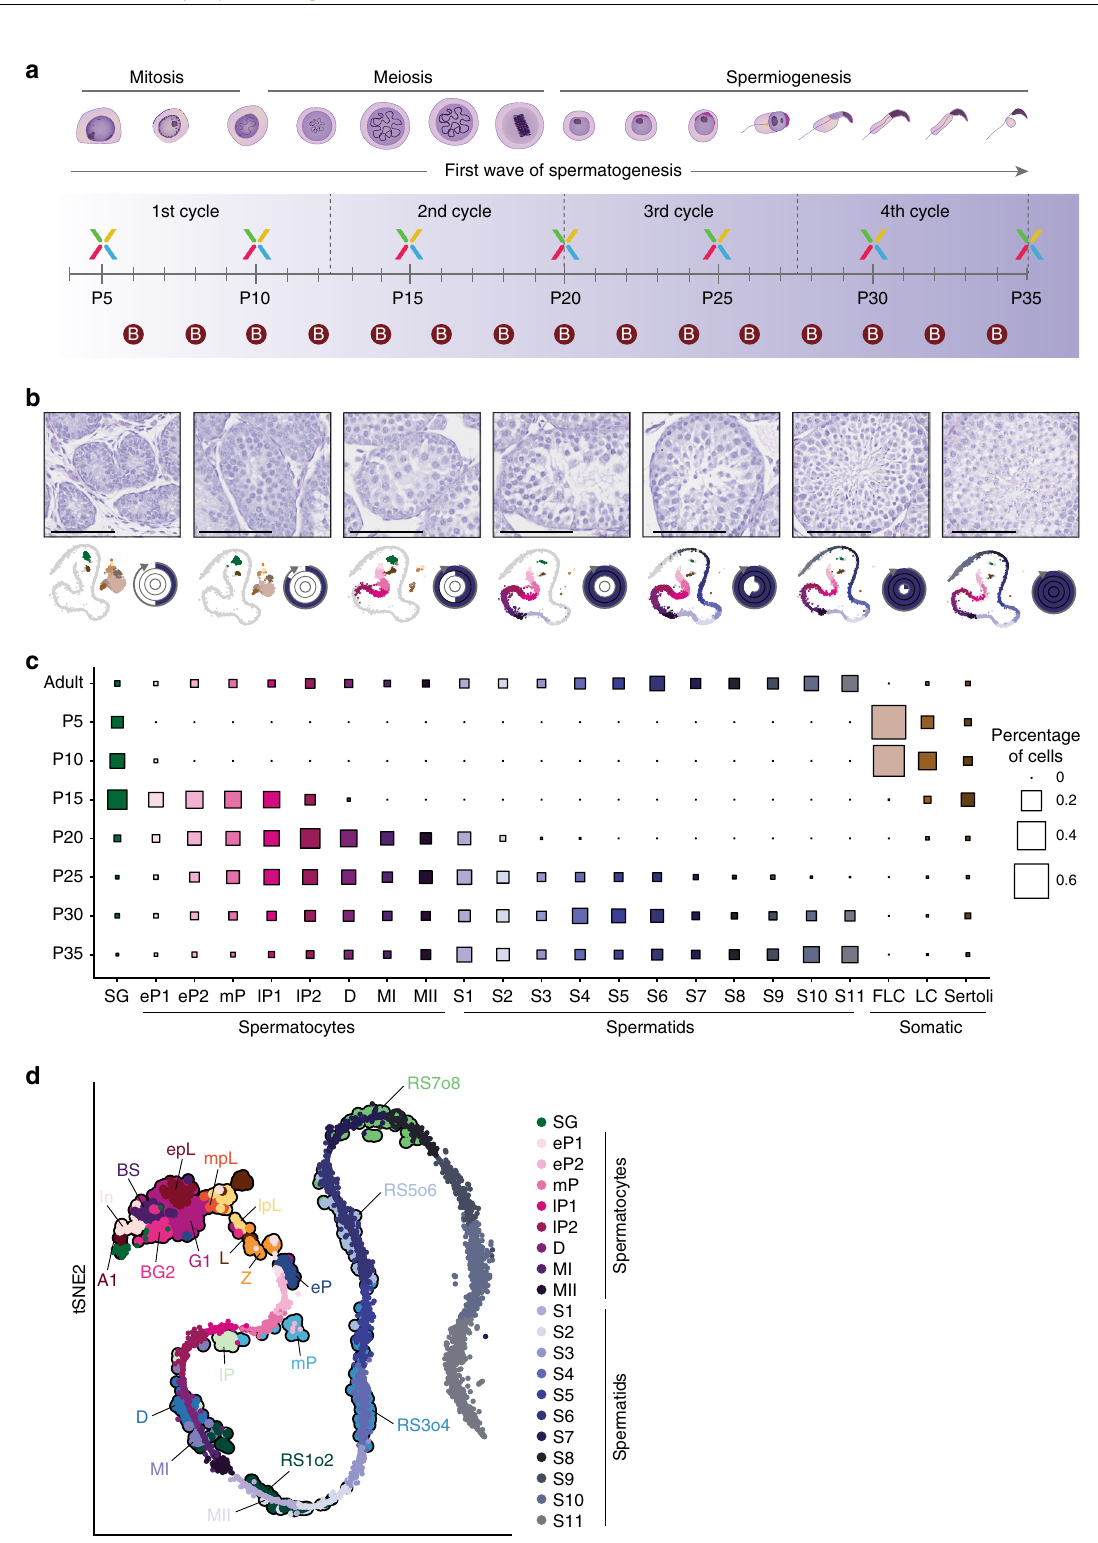
The third population expressed markers for spermatogonial differentiation such as Stra8 (Stimulated by retinoic acid 8), in accord with pro-spermatogonia directly transitioning into differentiating spermatogonia 32 (Supplementary Fig. 5a). To capture the full spectrum of spermatogonial differentiation, we combined cells annotated as spermatogonia from P10 and P15 to obtain 1165 transcriptional pro fi les (Fig. 3a, b) before ordering